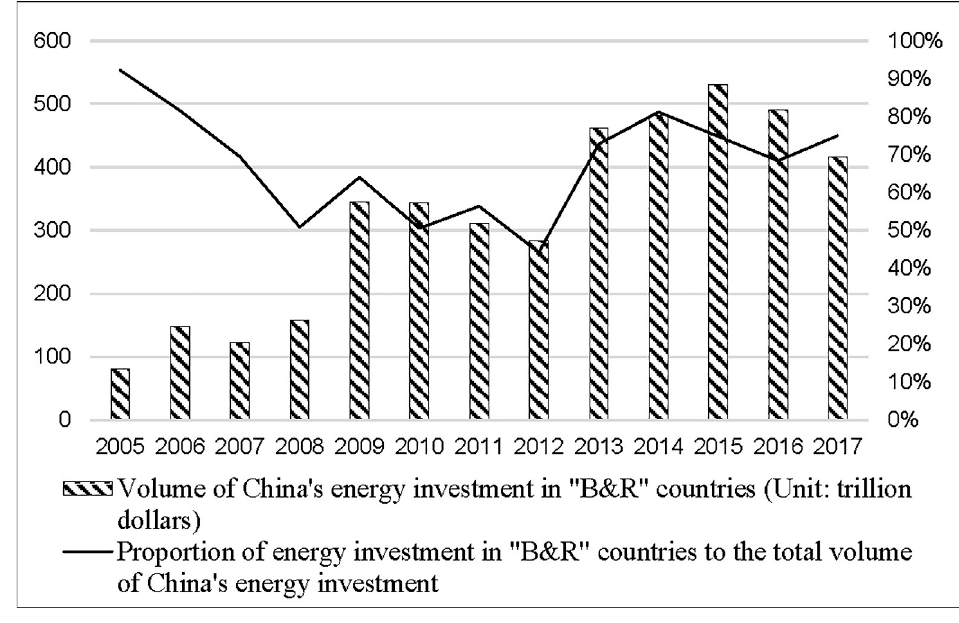
Fig 1. China’s OFDI in energy sector to “B&R” countries from 2005 to 2017. Fig 1 shows the investment of Chinese energy companies in “B&R” countries from 2005 to 2017. The investment covers petroleum, hydropower, alternative energy, natural gas and coal. The data is available from the China Global Investment Tracker database released by the American Enterprise Institute and the Heritage Foundation.